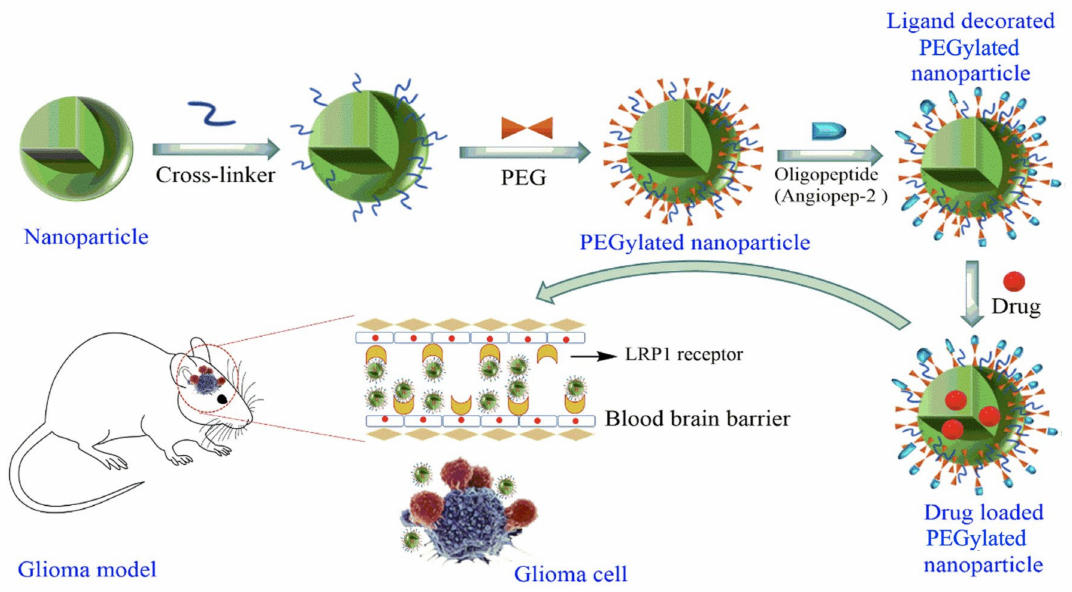
Figure 4. Diagrammatic representation of polyethylene glycolated (PEGylated) nanoparticle for improved blood circulation decorated with ligand (angio-peptide 2), an oligopeptide that has an a ffi nity for the low-density lipoprotein receptor-related protein 1 (LRP1) receptor on brain endothelial cells, allowing targeted drug delivery across the blood–brain barrier in